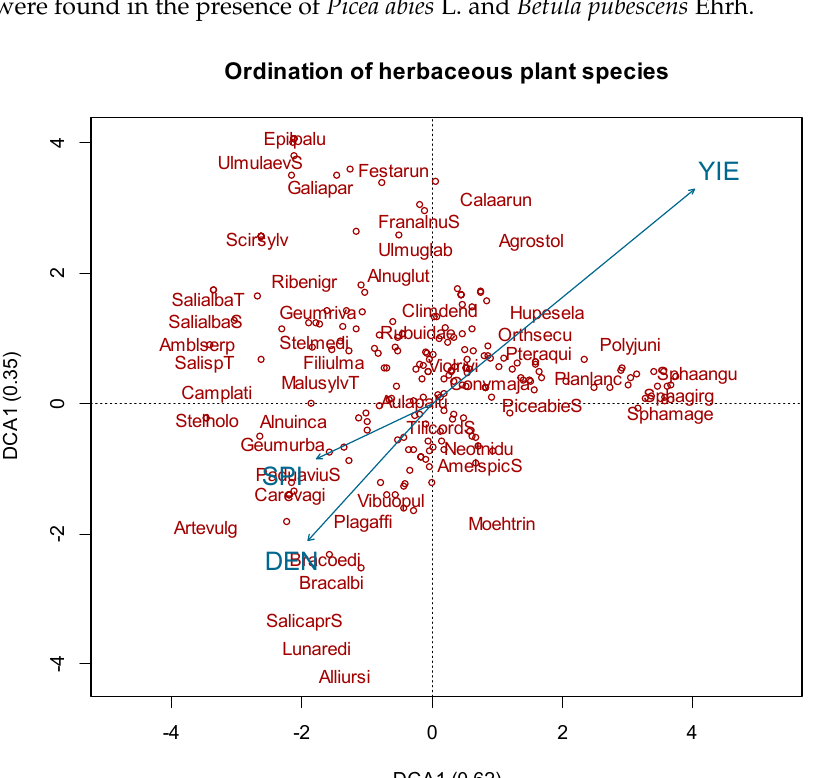
Figure 3. Grouping of tree and shrub species: results of detrended correspondence analysis. Analyzed factors: density (DEN), stream power index (SPI), total yeld (YIE). Letters “T” and “S” at the end of words represent the tree or shrub layer that they were classified into.